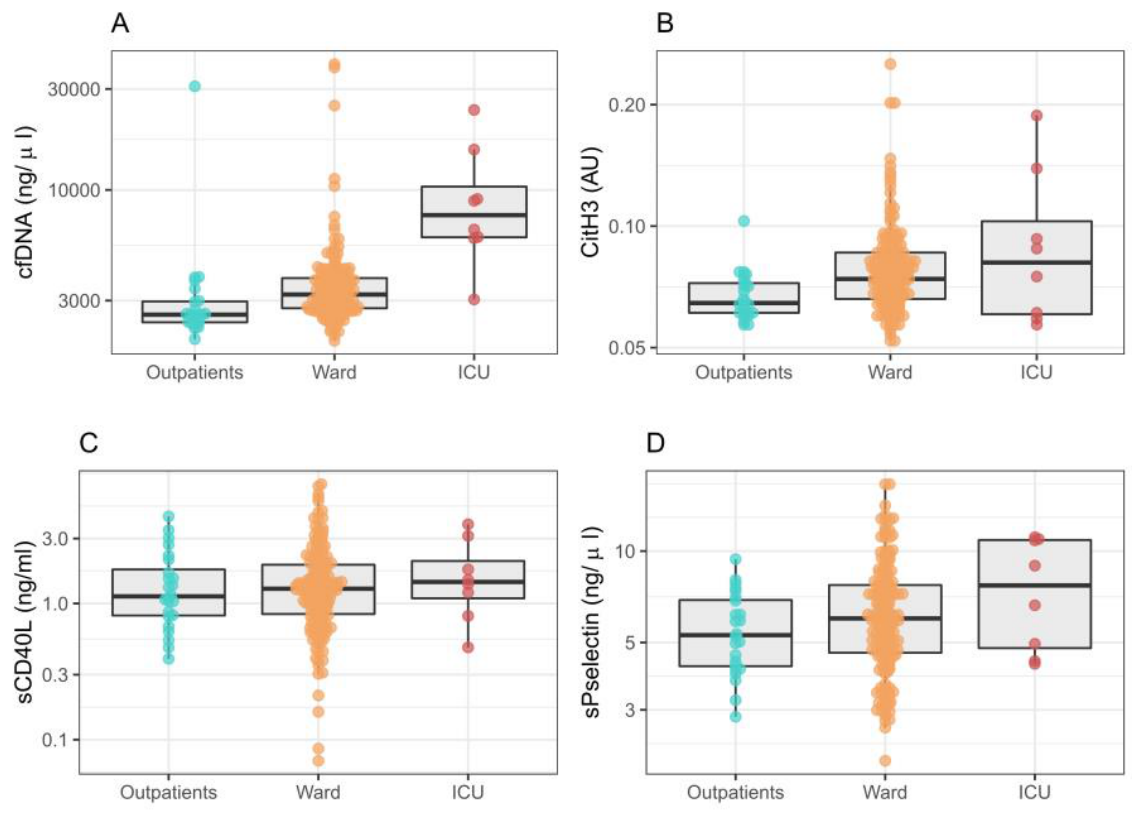
Figure 1. Neutrophil extracellular traps and platelet activation in relation to medical care needed in patients with COVID-19: outpatient, conventional ward admission and initial ICU admission. p - value from ordinal regression for discrimination among groups. ( A ) cfDNA levels; OR 6.76 [95% CI 2.95, 17.08], p < 0.001. ( B ) CitH3 levels; OR 12.90 [2.69, 62.68], p = 0.001. ( C ) sCD40L levels; OR 1.106 [0.654, 1.853], p = 0.706. ( D ) sP-selectin levels; OR 2.45 [0.95 – 6.44], p = 0.066. AU: arbitrary units.